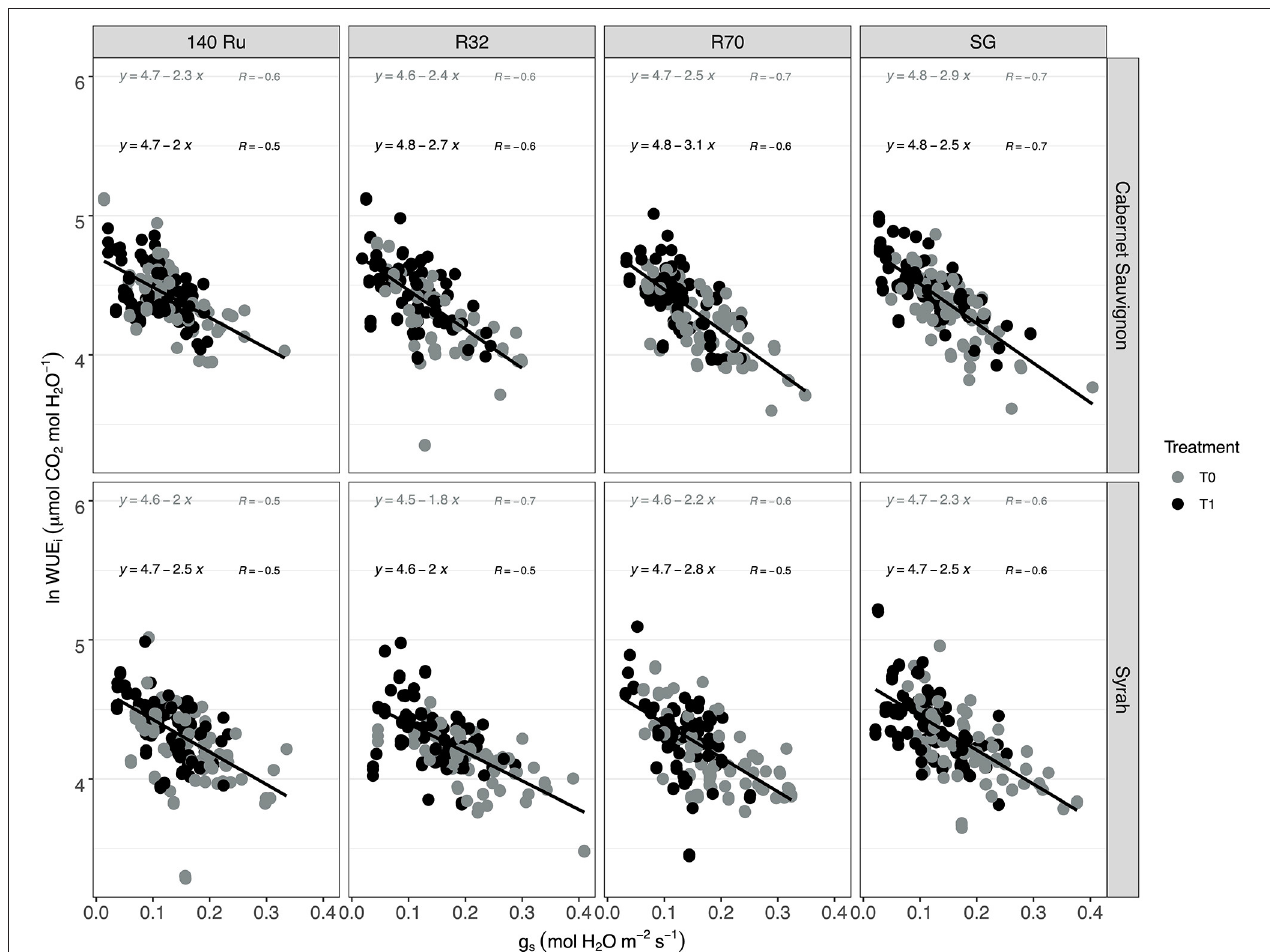
FIGURE 3 | The relationships between linearized intrinsic water use efficiency (ln WUE i ; A n /g s ) vs. stomatal conductance (g s ) in two cultivars (CS and Sy) over different rootstocks under two irrigation